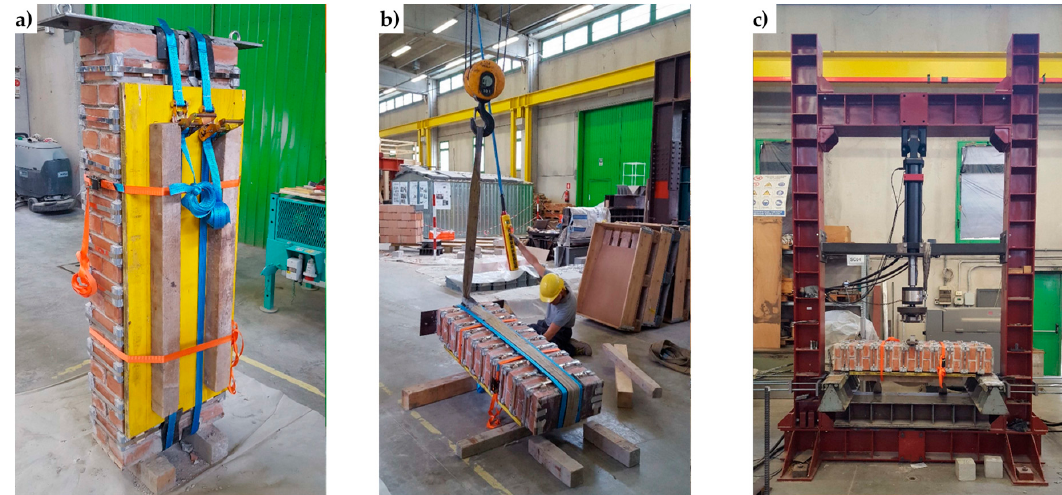
Figure 37. Manual strapping tool for steel.